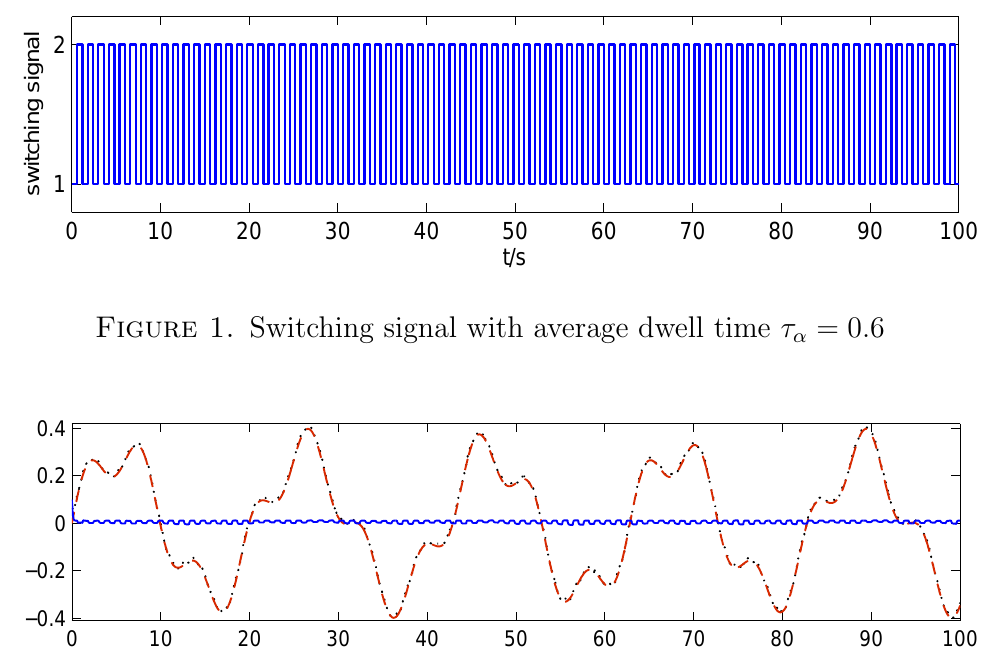
Figure 2. Tracking performance of output y